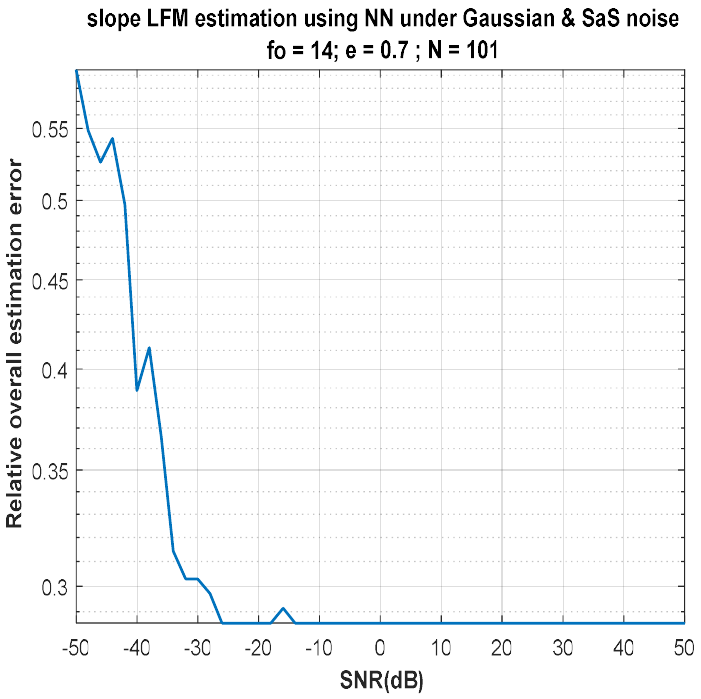
Figure 16. Error rate for SE of noisy LFM signals by DNN.